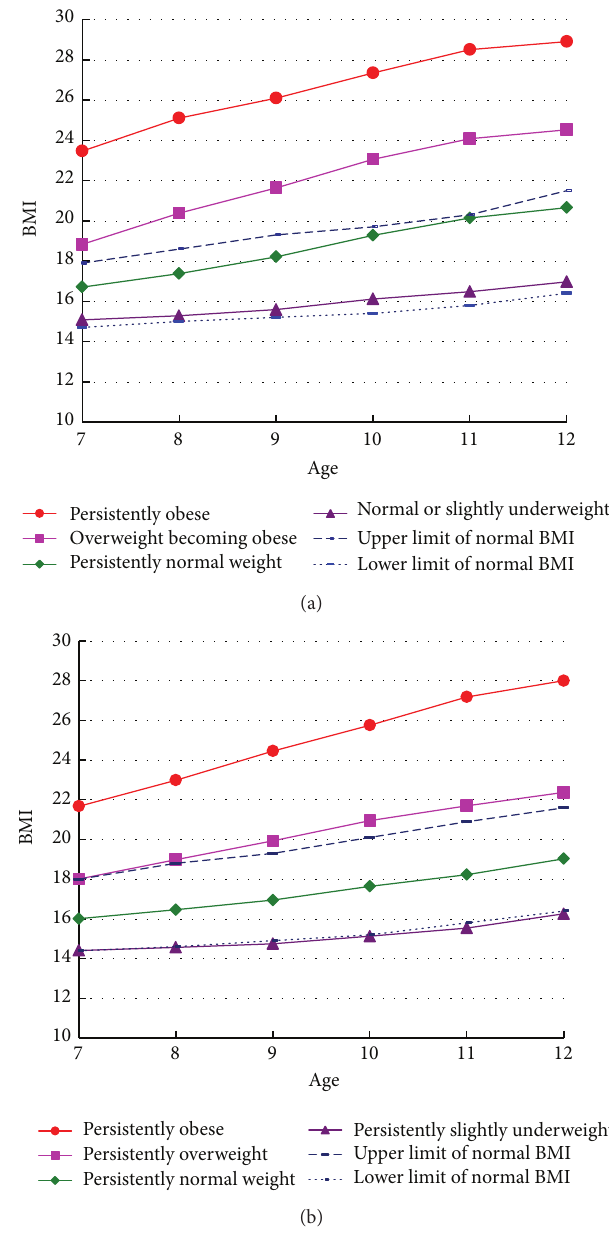
Figure 1: BMI developmental trajectory groups in boys and girls from ages 7 to 12 years (upper graph is boys and the lower graph is